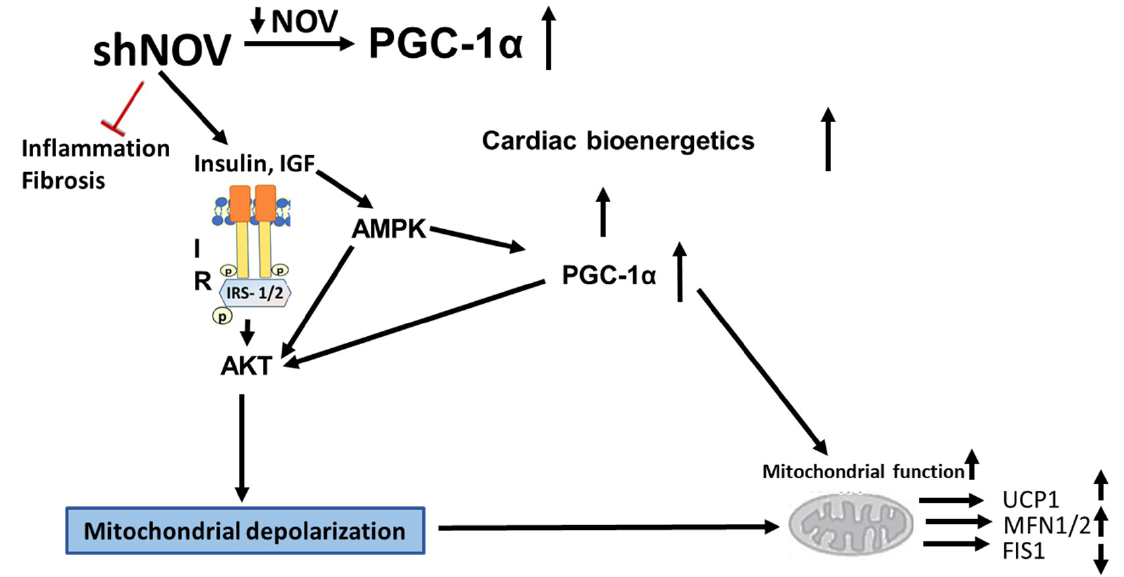
Figure 12. Diagram showing the possible mechanisms by which the silencing of NOV expression improves mitochondrial function, biogenesis, and integrity. The silencing of NOV (shNOV) attenuates HFD-induced inflammation and fibrosis. Insulin sensitivity is improved, leading to the activation of AKT (Protein kinase B). The increase in HO-1 also activates PGC-1 α (peroxisome proliferator-activated receptor-gamma coactivator), improving mitochondrial function. The increased AKT activity might lead to increased autophagy. The elevation in autophagy, together with mitochondrial depolarization as a result of oxidative stress, might increase mitophagy. Therefore, damaged mitochondria are removed, and the mitochondrial protein levels of UCP1 (uncoupling protein 1) and MFN1/2 (mitofusion 1 and 2) are increased, while FIS1 (mitochondrial fission 1 protein), expression is attenuated. Ultimately, mitochondrial function is